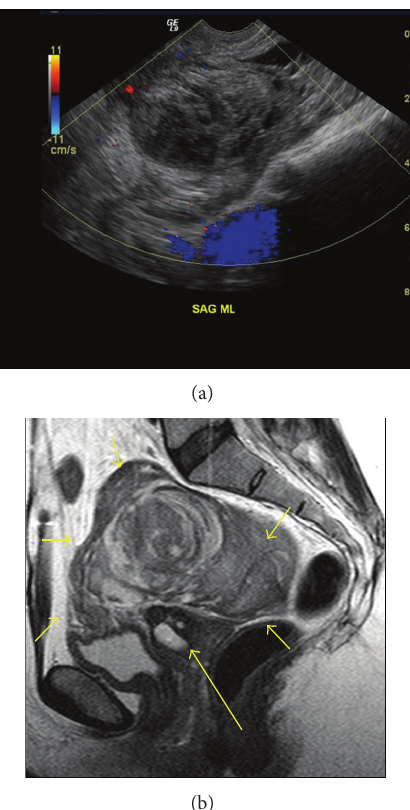
Figure 1: Image (a) is a transvaginal sagittal image with Doppler through the midline pelvis demonstrating a large central heteroge- neous mass in the pelvis which does not show internal flow likely representing an organizing hematoma. Image (b) is a T2 weighted sagittal MR image through pelvis showing a large central pelvic hematoma (small arrows). A prominent cervical stump containing a nabothian cyst (large arrow) is noted posterior to the bladder.